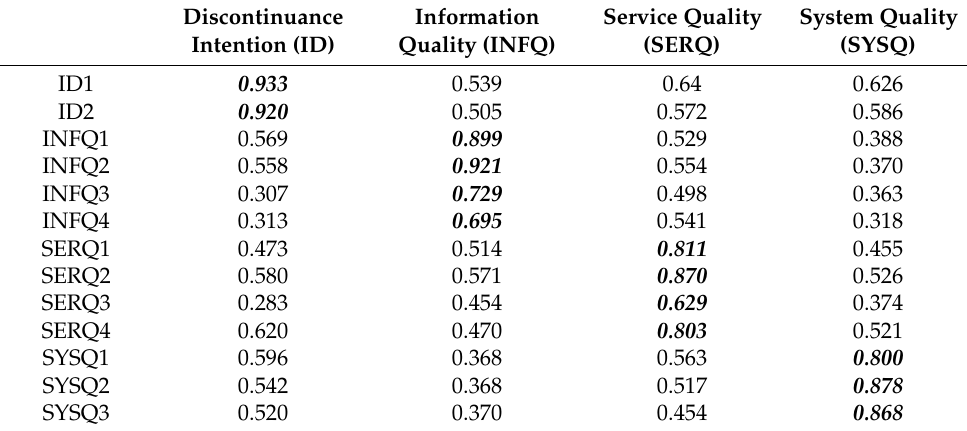
Table 2. Factor loadings and cross-loadings for the measurement model.